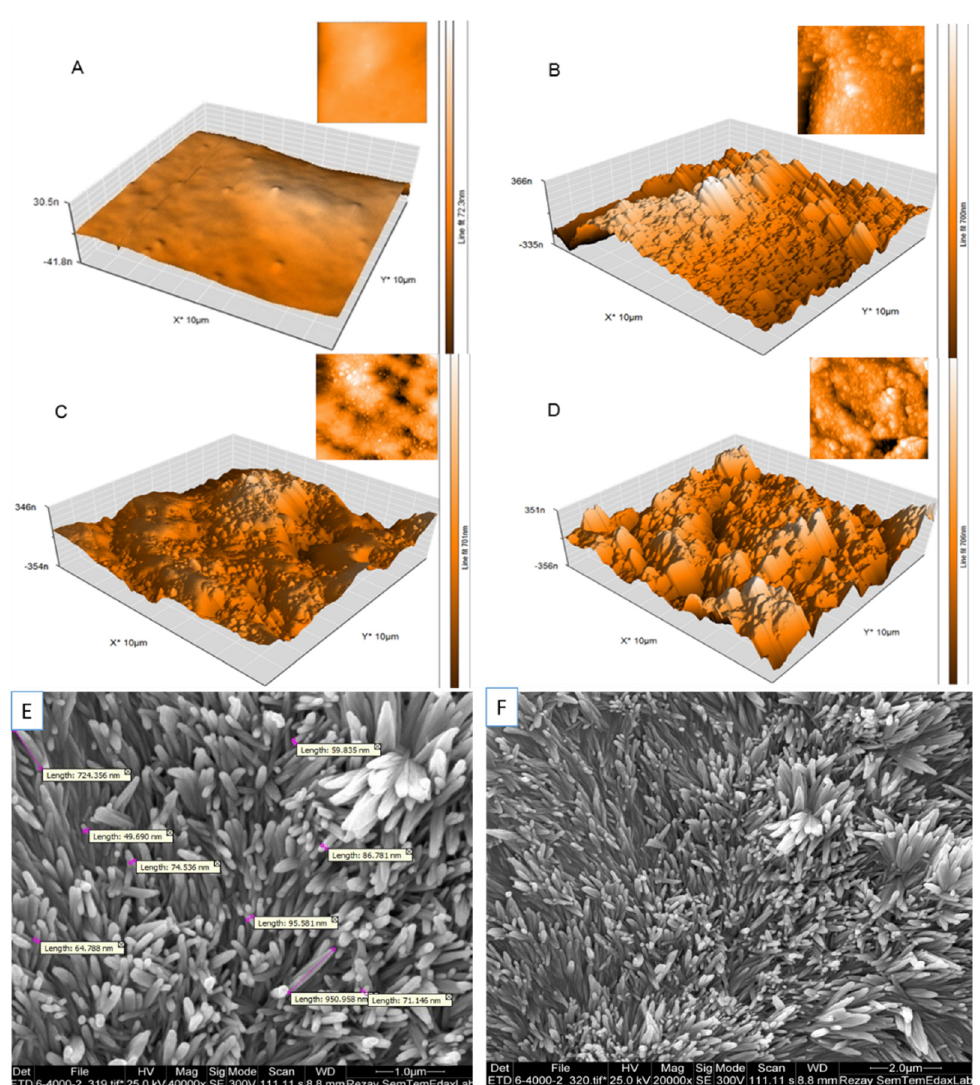
Figure 2. Substratum atomic force microscopy (AFM) topography of unmodified ( A ) and modified PDMS surfaces with nanoparticle coating: GO ( B ), GQD ( C ), SPION ( D ), recorded in tapping mode. The contrast covers height variations in the 0–30 nm scale in A and in the 0–350 nm scale in B, C, and D. Scanning electron microscopy image of the morphology of gold nanowires mixed up with PDMS ( E and F ).